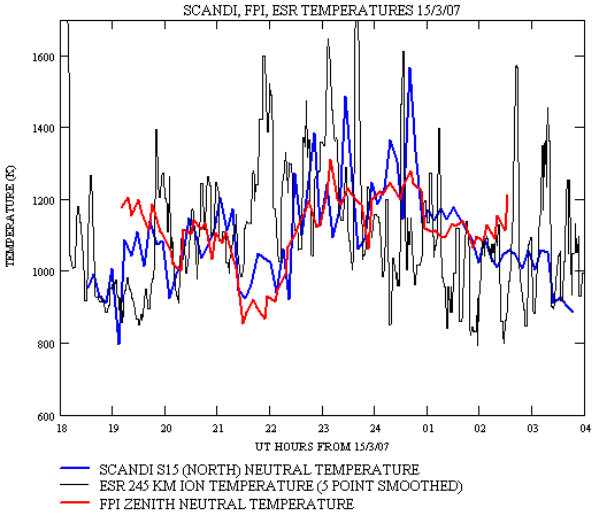
Fig. 4. SCANDI zone 15 (North) neutral temperatures compared with FPI zenith neutral temperatures and ESR ion temperatures (5 point smoothed) from 245km altitude for 15 March 2007.